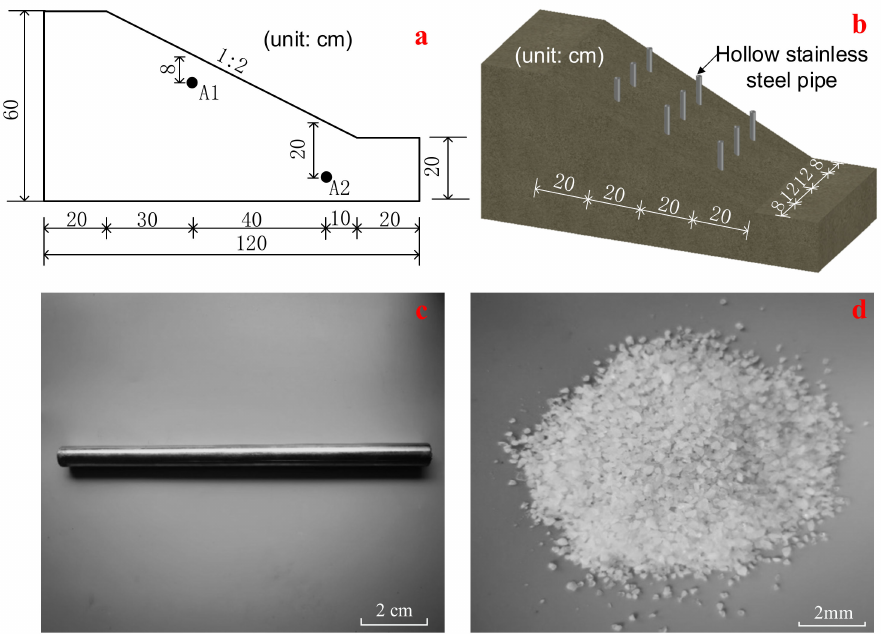
Figure 3. Macropore slope model: ( a ) Geometric model of the slope; ( b ) Location of macropores; ( c ) Stainless-steel hollow pipe; ( d ) Coarse-grained quartz sand.